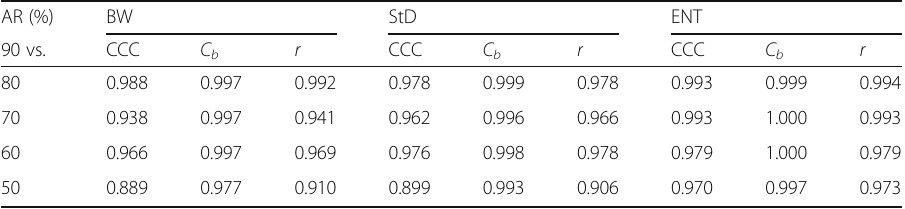
Table 3 Concordance correlation coefficients for TOSEM reconstructions for patients whose unaltered activity ratio was > 90% AR (%) BW StD ENT 90